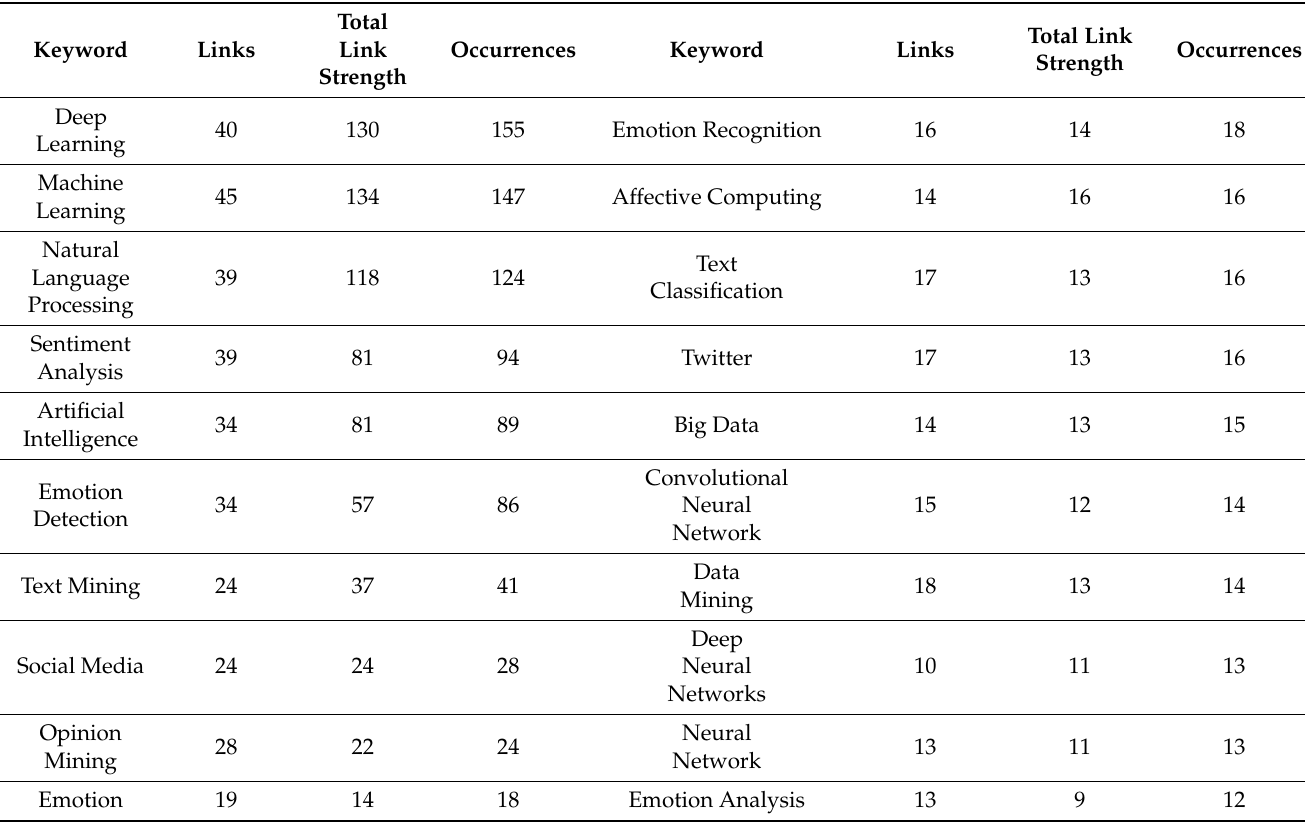
Figure 15. Keyword co-occurrence network diagram. Table 14. The top 20 author keywords, their total link strength, and